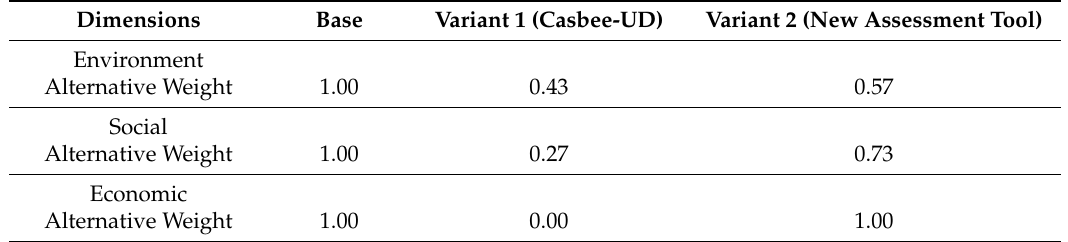
Table 10. Multi-criteria AHP evaluation results depicting final score of each alternative. Dimensions Base Variant 1 (Casbee-UD) Variant 2 (New Assessment